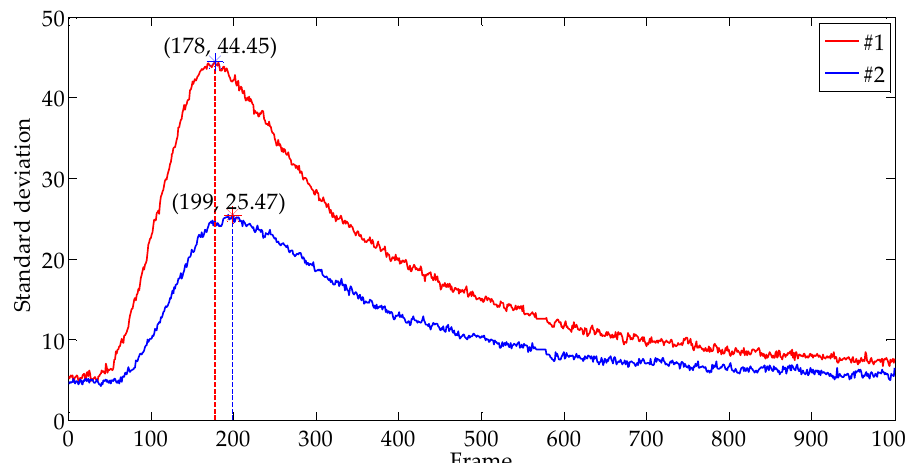
Figure 14. A suitable frame for each defect is determined by the maximum of sandard deviation of sensitive region method (MSDSRM) using single sensitive region.